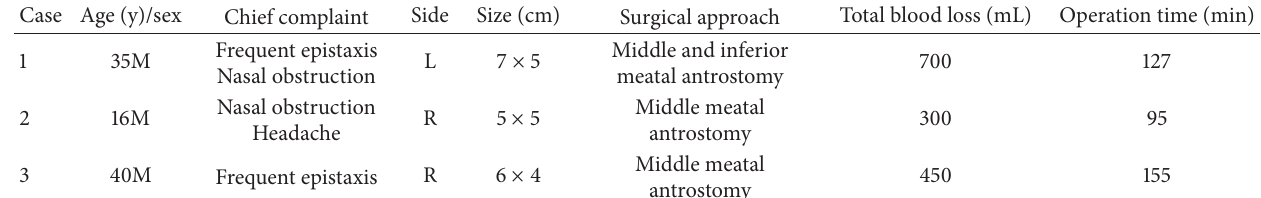
Table 1: Clinical characteristics of the three cases.